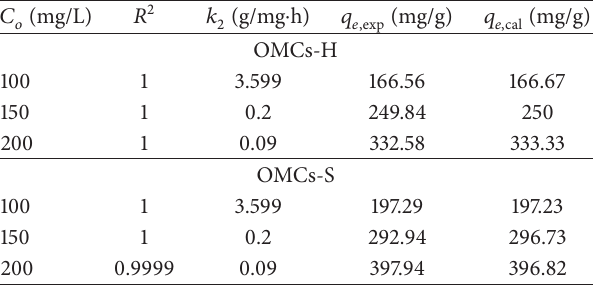
Table 6: Rate adsorption constants and MB adsorption capacities calculated according to pseudo-second-order equation of OMCs-H and